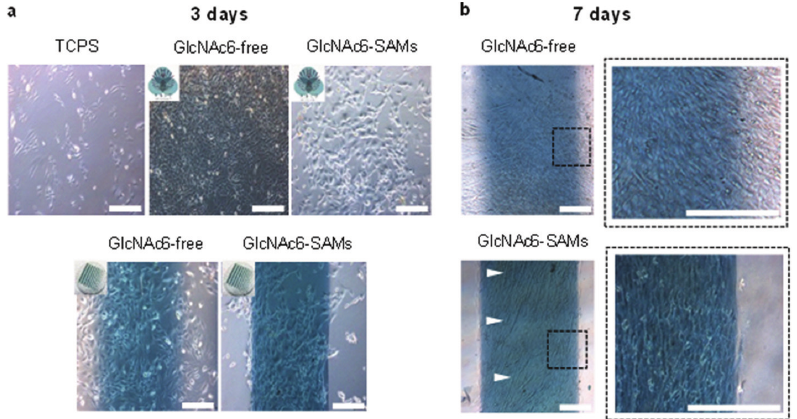
Figure 3. Representative phase-contrast microscopic images of mouse myoblast C2C12 cells ( a ) three days and ( b ) seven days after cell seeding on GlcNAc6-SAMs and GlcNAc6-free, with and without gold micropatterned substrates. The alignment of cultured cells was clearly dependent on GlcNAc6-SAM patterns, demonstrating a densely packed cellular assembly with the outermost cells along the edge of gold micropatterns, as shown in a dashed box. The white arrows indicated the elongated myoblasts. Scale bars correspond to 200 μm.